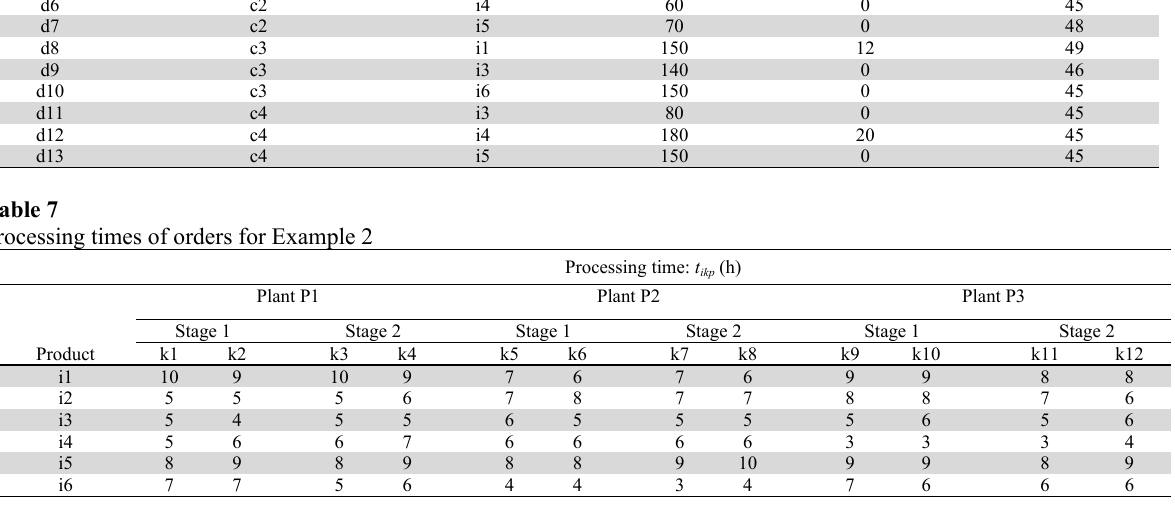
Parameters associated for each order at Example 2 Order